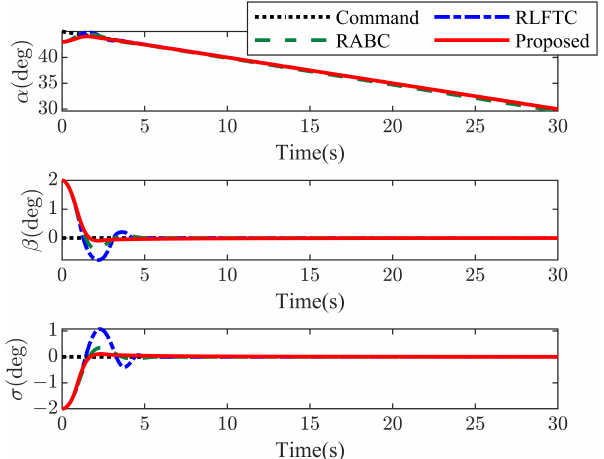
Figure 2. Time histories of the attitude angles.